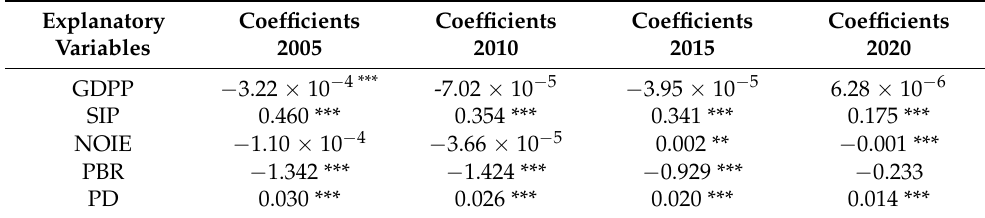
Table 3. China regional PM2.5 concentration global Moran index.